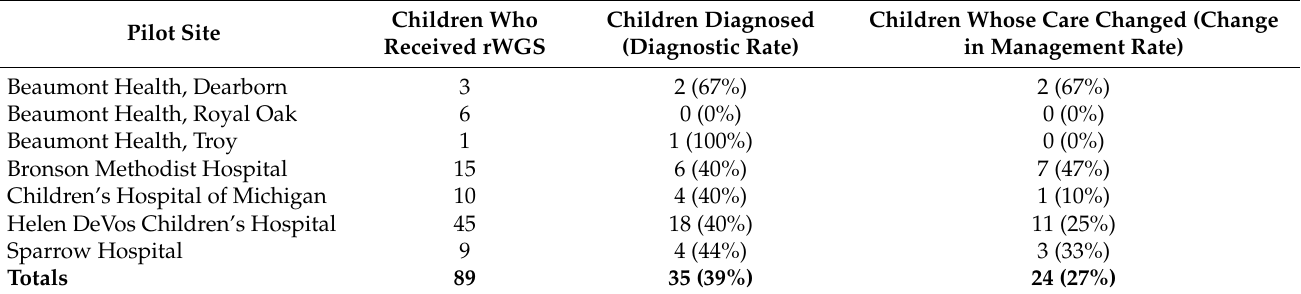
Table 3. Diagnostic Rate and Change in Management Rate by